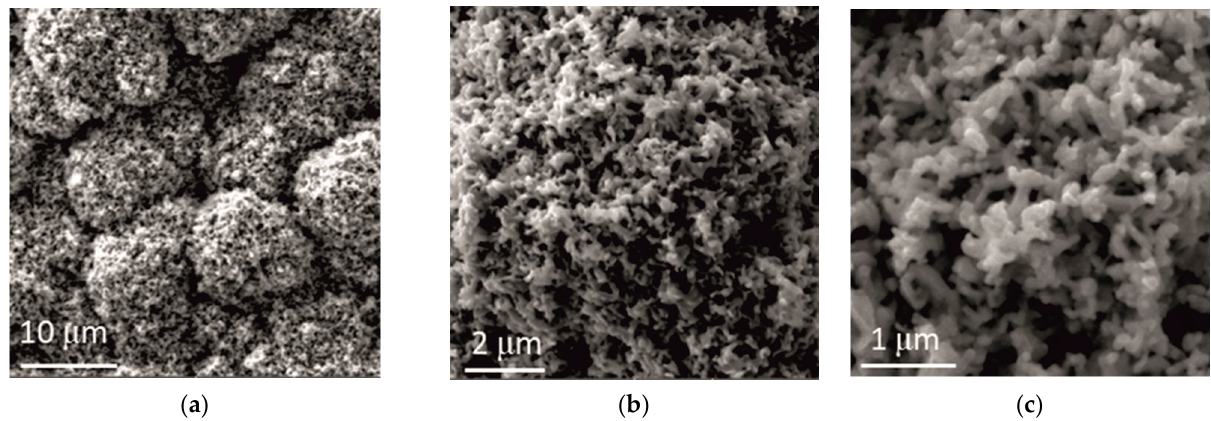
Figure 7. Morphology of Zn-Co-CeO 2 coating obtained by electrodeposition at a current density of 2 A dm − 2 from the electrolyte with an addition of CeO 2 in the form of sol. Magnification: ( a ) ×5000, ( b ) ×20,000 and ( c ) ×50,000.